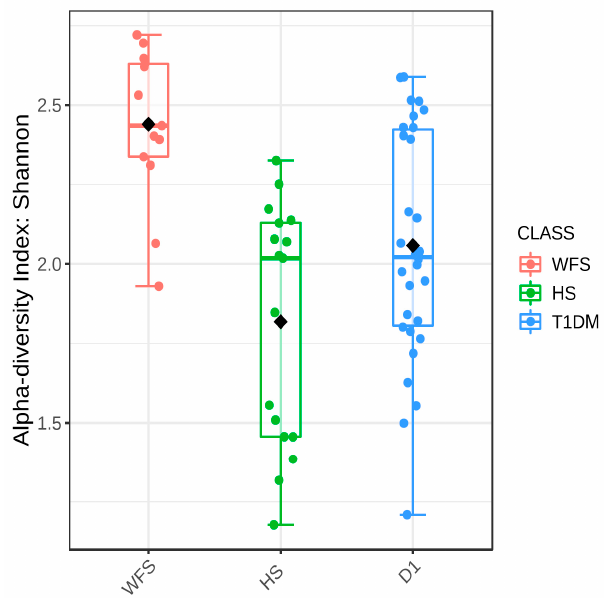
Figure 3. Boxplot showing the overall measure of alpha-diversity in the groups studied using the Shannon method at the bacterial genus level. WFS—Wolfram syndrome; HS—healthy subjects; T1DM—Type 1 diabetes mellitus. The black dot indicates the average value. Statistical significance was evaluated by ANOVA F-value: 12.038; p -value < 0.0001.